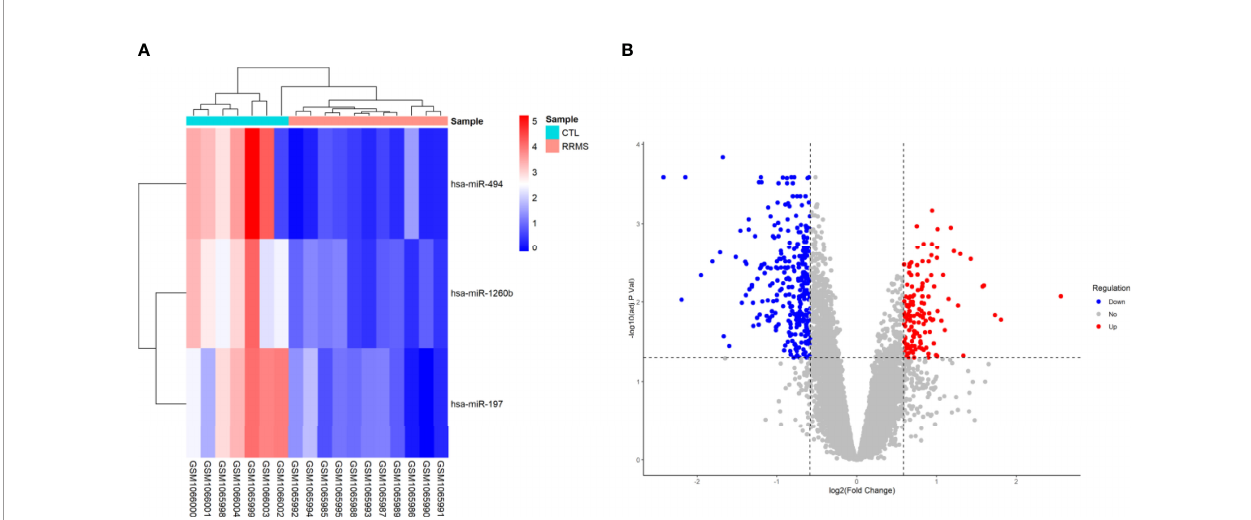
FIGURE 2 | Differentially expressed genes between relapsing-remitting multiple sclerosis (RRMS) samples and control (CTL) samples. (A) Heatmap of the DEmiRNAs in dataset GSE43590. The normalized relative expression values are in a range between zero and fi ve. High expressed genes are shown in red, while those expressed at low levels are blue. (B) Volcano plot for the DEmRNAs and DElncRNAs in dataset GSE43591. The x-axis shows the log Fold Change, and the y- axis shows the -log10 (adjusted P -value). Upregulated and downregulated genes are represented by red and blue dots, respectively. The gray dots represent genes with no signi fi cant difference. The DEGs were screened according to a |(log2FC) ≥ 0.585 and an adjusted P -value <